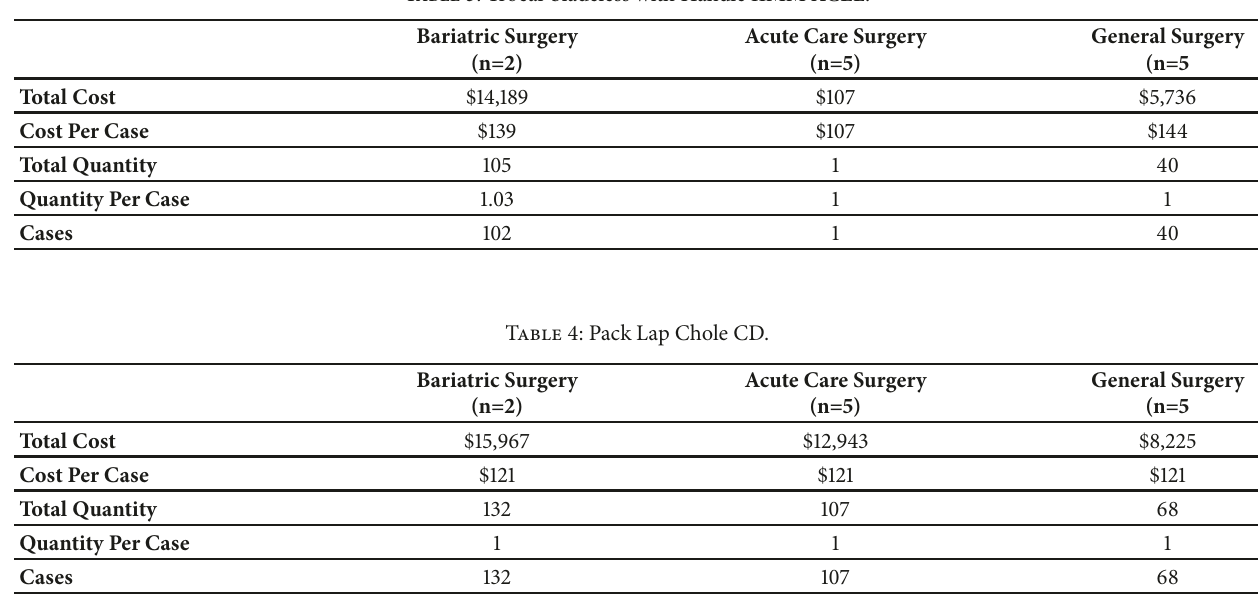
Table 3: Trocar bladeless with Handle 11MM XCEL.